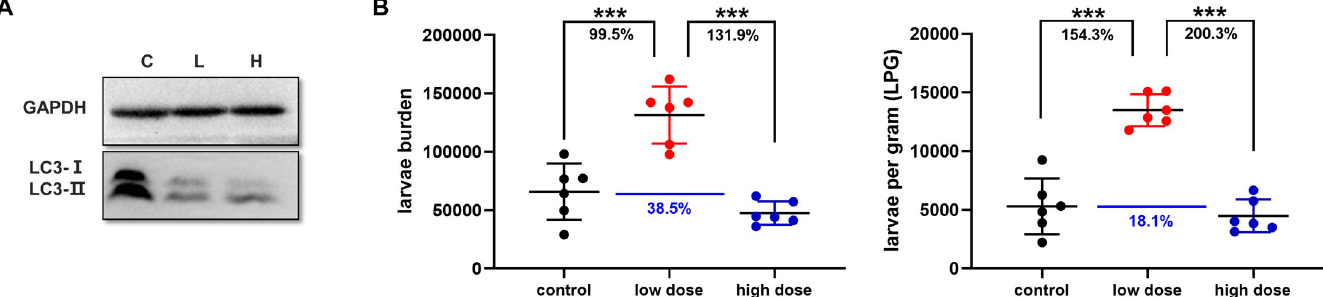
Fig 5. Slight inhibition of autophagy conduced the growth of T . spiralis , while severe inhibition of autophagy suppressed its survival. A. The diaphragmatic muscle LC3-II expression level after the use of autophagy inhibitor 3-MA on 28 dpi. C: control; L: low dose (5 μ g/g); H: high dose (10 μ g/g). B: The larvae burden and LPG of mice in the control, low-dose, and high-dose groups. Each group contained at least six mice and the data are expressed as mean ± SD. p < 0.05( � ), p < 0.01( �� ), p < 0.001 ( ��� ).